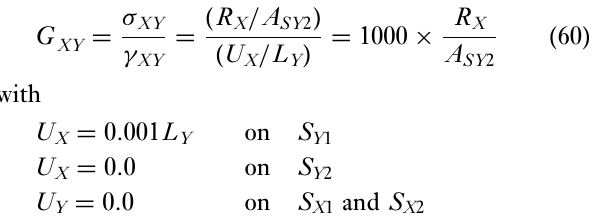
Figure 2. As shown in the figure, a uniform displacement = 0.001 L field U , which is equivalent to a strain ε X X 0.001, is prescribed on the surface S = 0.0, is prescribed on the surface S U X